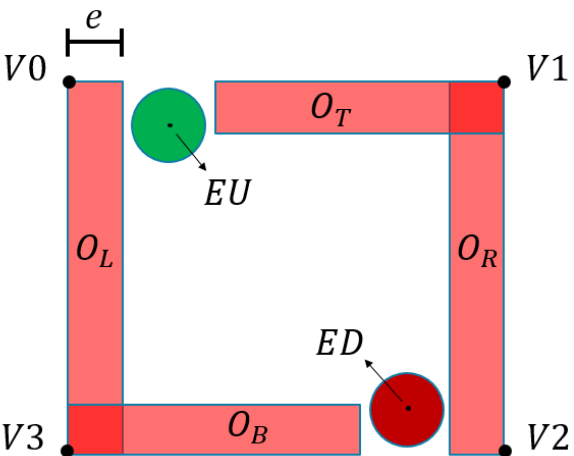
Figure 5. Details of building which have entrances (green circles) and exits (red circles).